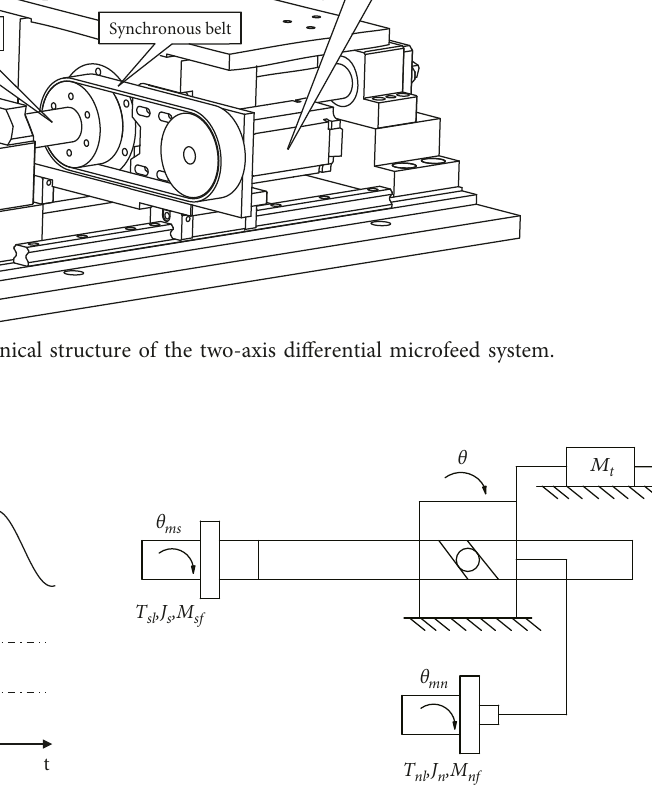
Figure 2: Drive shaft speed distribution.